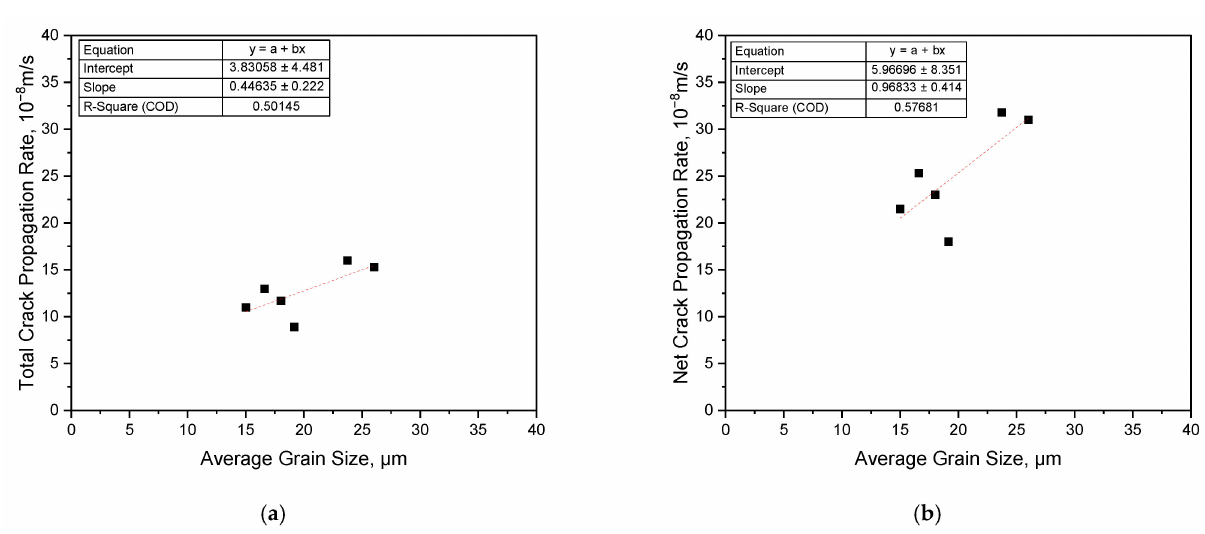
Figure 12. Relationship between the crack propagation rate and average grain size: ( a ) total crack propagation rate, ( b ) net crack propagation